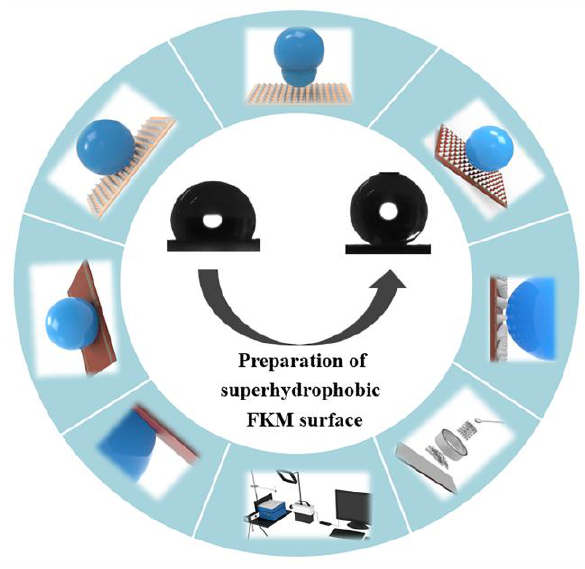
Figure 1. Fluororubber surface superhydrophobic.